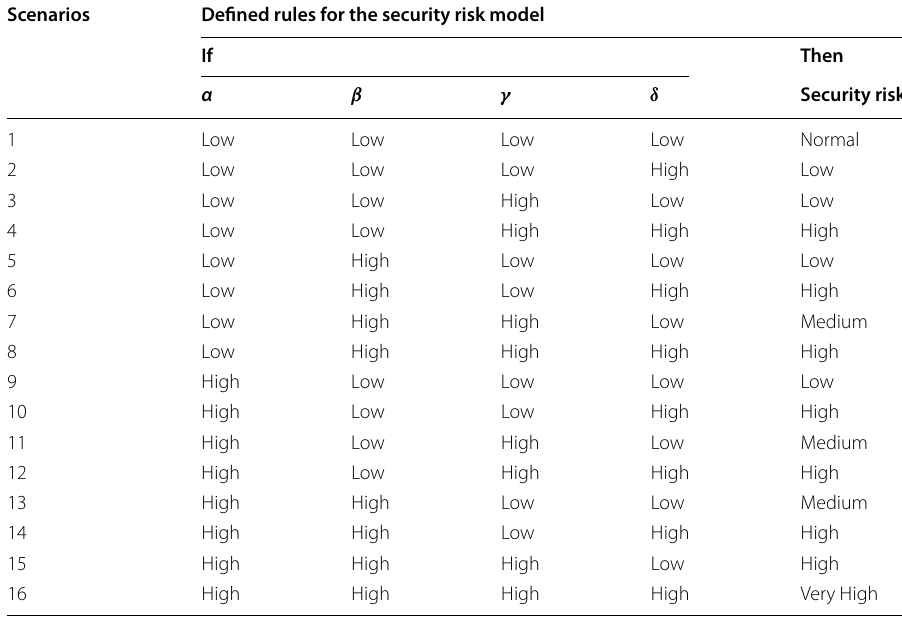
Table 2 Updated rules for the scenarios of all the monitored parameters Scenarios